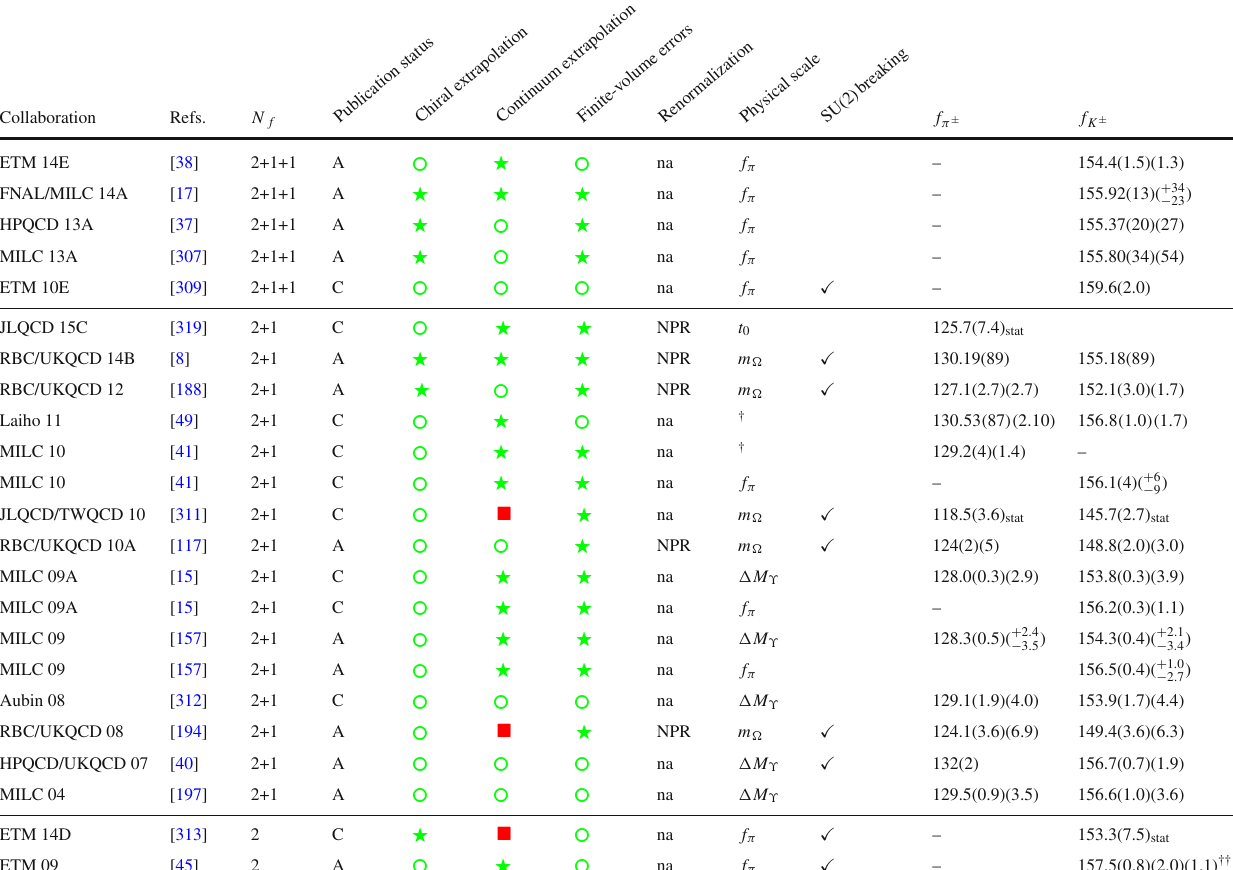
Table 20 Colour code for the lattice data on f π ± and f K ± together with information on the way the lattice spacing was converted to physical units and on whether or not an isospin-breaking correction has been applied to the quoted result (see Sect. 4.3). The numerical values are listed in MeV units. In this and previous editions [4], old results with two red tags have been dropped